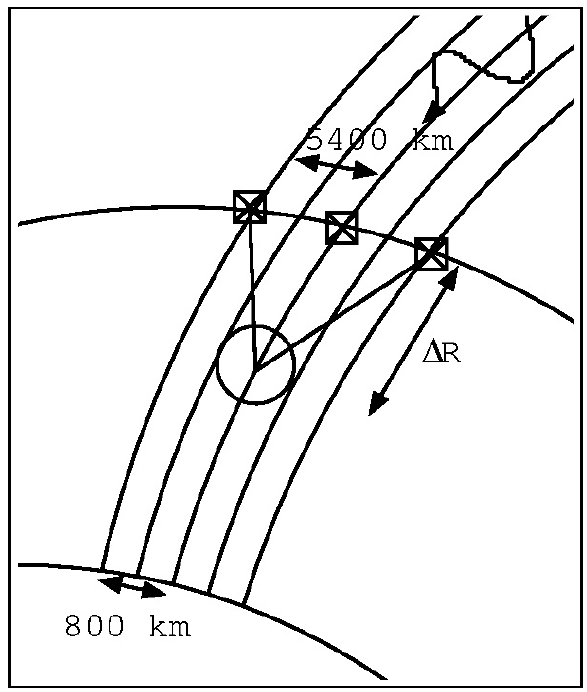
Fig. 10. The dot-AKR generation region (circle) may send AKR to any of the depicted Interball positions, although the Alfv´en waves probably exist only on the flux tube of the generation region; thus, the satellite need not necessarily detect Alfv´en waves when it de- tects dot-AKR even if Alfv´en waves and dot-AKR always occur